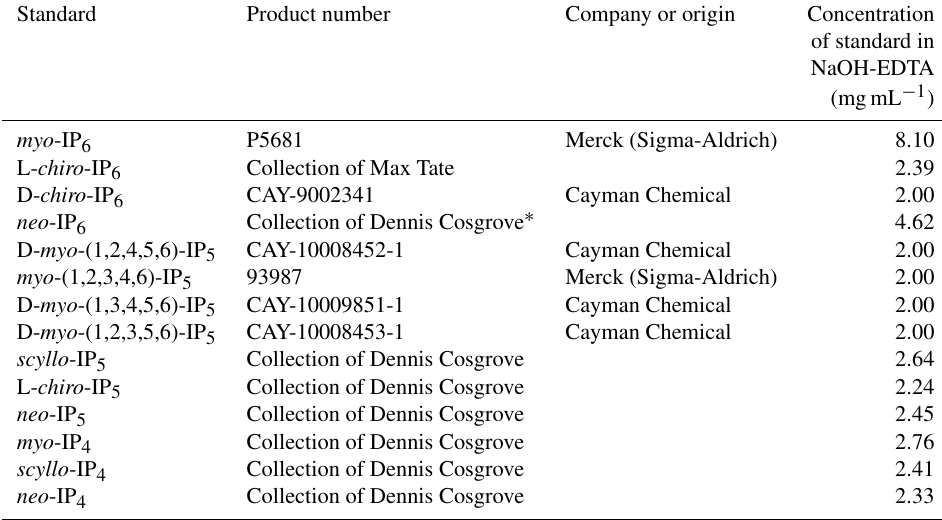
Table 2. Standard solutions used for the spiking experiment of the hypobromite oxidised soil extracts. All standards were dissolved in 0.25M NaOH and 0.05M Na 2